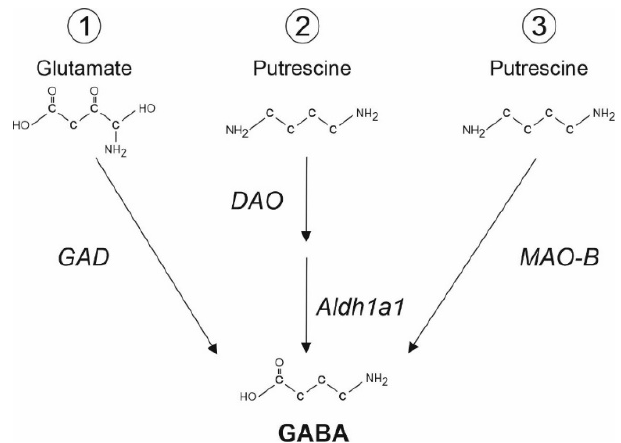
Figure 1. Several pathways of GABA synthesis in astrocytes. ( 1 ) Glutamate decarboxylase (GAD) can convert glutamate into GABA [28]. ( 2 , 3 ) GABA can be synthesized from putrescine, a monoamine, via ( 2 ) Diamine Oxydase (DAO) and Aldehyde Dehydrogenase 1a1 (Aldh1a1, [34]) or ( 3 ) Monoamine oxidase B (MAO-B, [35]).